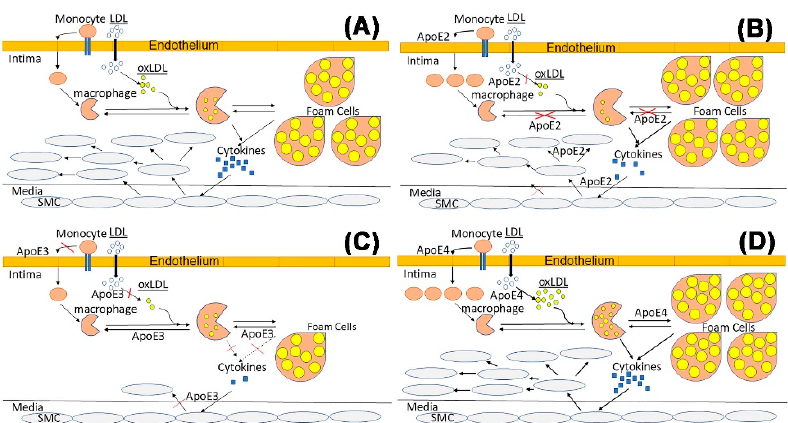
Figure 2. Schematic diagrams on the influence of apoE in atherosclerosis. ( A ) General schematics of the atherosclerosis process. ( B ) Mechanisms underlying the influence of apoE2 in accelerating atherosclerosis. ( C ) Mechanisms underlying the protective roles of apoE3 on atherosclerosis develop- ment. ( D ) Mechanisms underlying the influence of apoE4 in accelerating atherosclerosis.